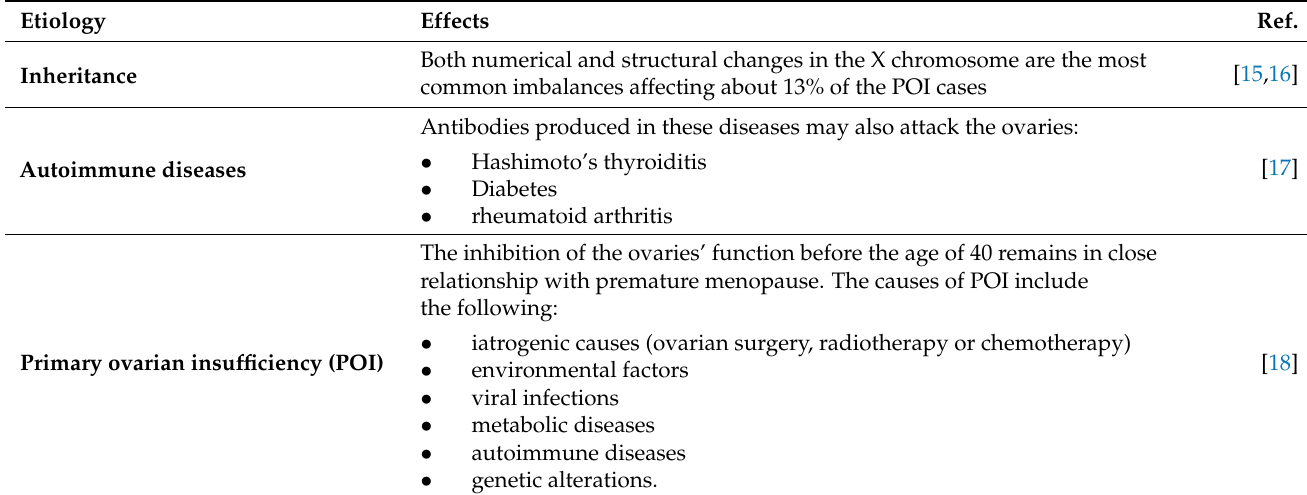
Table 1. Causes of premature menopause.